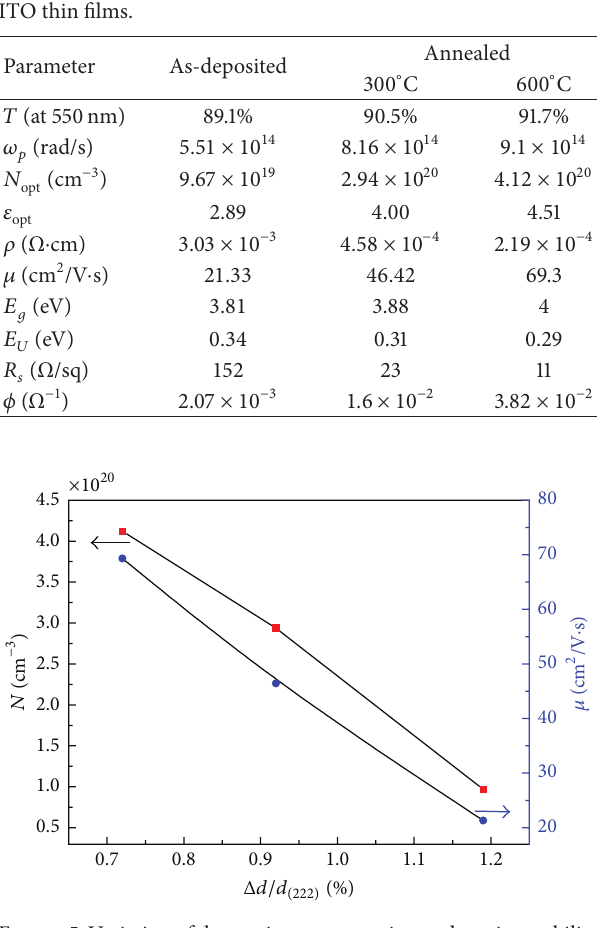
Figure 5: Variation of the carrier concentration and carrier mobility with the lattice distortion.